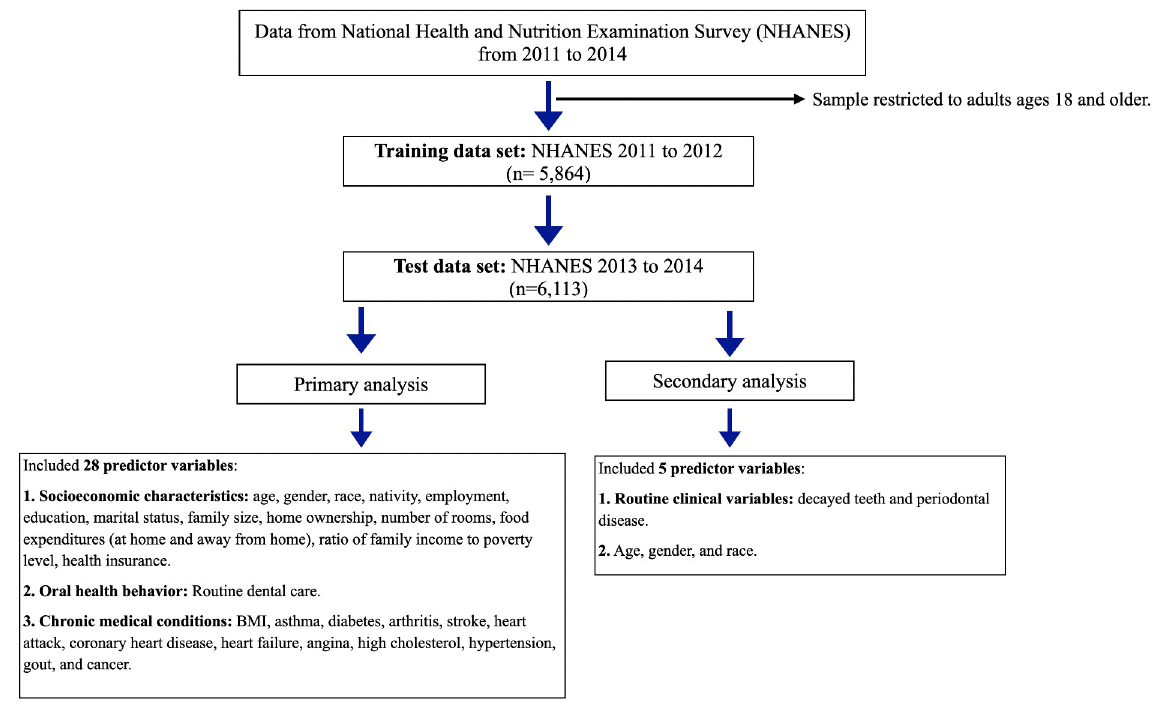
Fig 1. Study flow